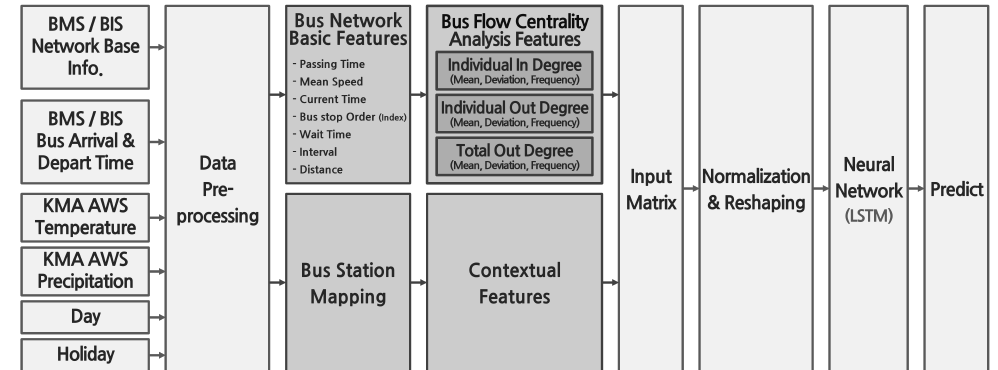
Figure 1. The overall procedure for bus flow centrality analysis (BFC) and training for bus arrival time prediction.